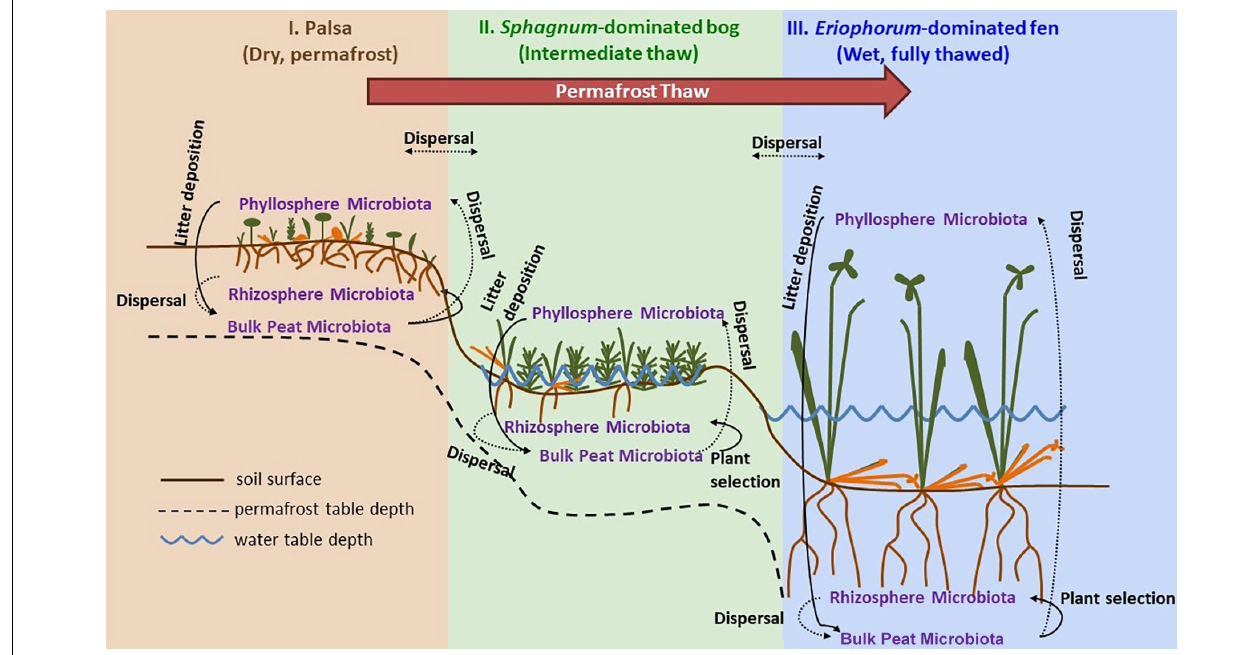
FIGURE 1 | Permafrost thaw progression showing directions of possible microbial dispersal in the context of changes in plant community composition and hydrology as ecosystems transition from: I. permafrost-underlain palsa, to II. partially thawed bog, to III. fully thawed and inundated fen. The underlying thaw progression figure has been adopted from Johansson et al. (2006) and modified